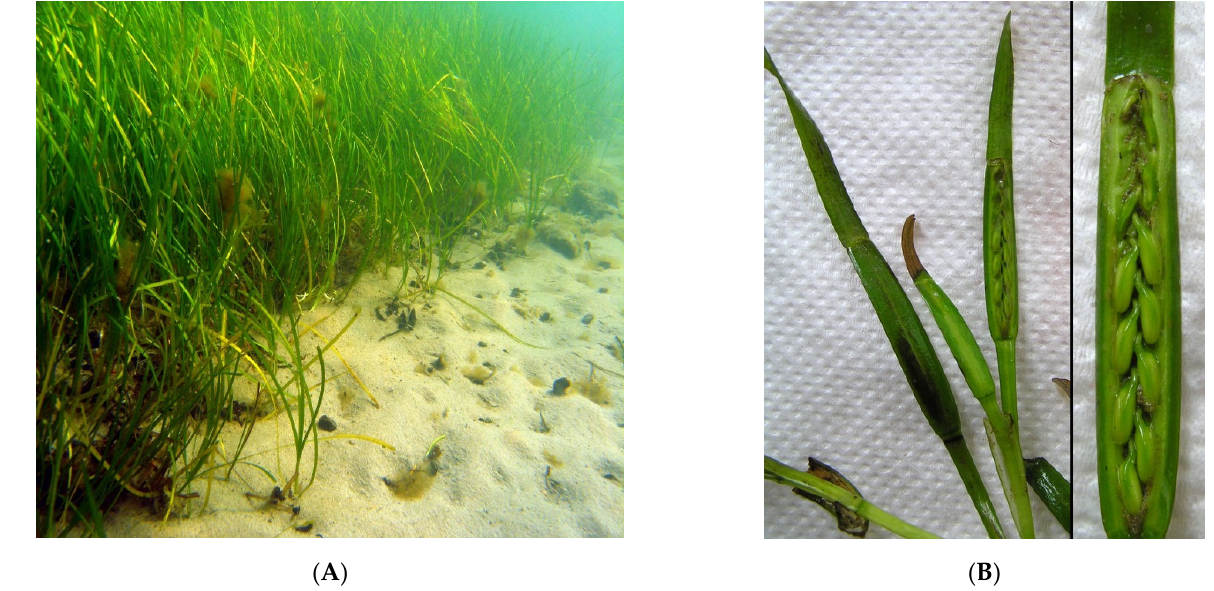
Figure 1. ( A )– Zostera marina L. (Peter the Great Gulf, Primorsky Krai, Russia); ( B )–Reproductive Figure 1. ( A )— Zostera marina L. (Peter the Great Gulf, Primorsky Krai, Russia); ( B )—Reproductive shoot of Z. marina L. shoot of Z. marina